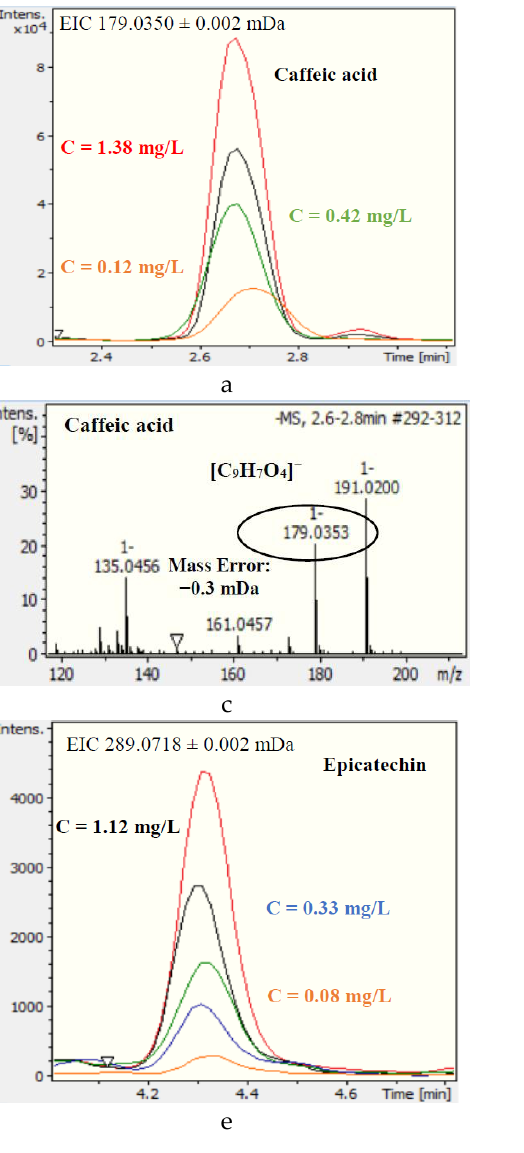
Figure 1. Extracted Ion Chromatograms and Mass Spectrometry (MS) spectra of epicatechin and caffeic acid in authentic and adulterated Hicaz pomegranate juices. ( a ) EIC of caffeic acid in authentic and adulterated pomegranate juice. ( b) Linear regression of caffeic acid and adulteration percentage. ( c ) MS spectra of caffeic acid. ( d ) MS spectra of epicatechin. ( e ) EIC of epicatechin in authentic and adulterated pomegranate juice. ( f ) Linear regression of epicatechin and adulteration percentage. Pomegranate juice adulteration from red grape juice could be detected based on the concentrations of epicatechin, catechin, hydroxytyrosol, and resveratrol. The presence of epicatechin in Hicaz pomegranate juice could reveal adulteration from red grape juice as low as 2% (at concentrations ≥0.25 mg/L) , while catechin was a relatively less indicative marker, as it also exists in